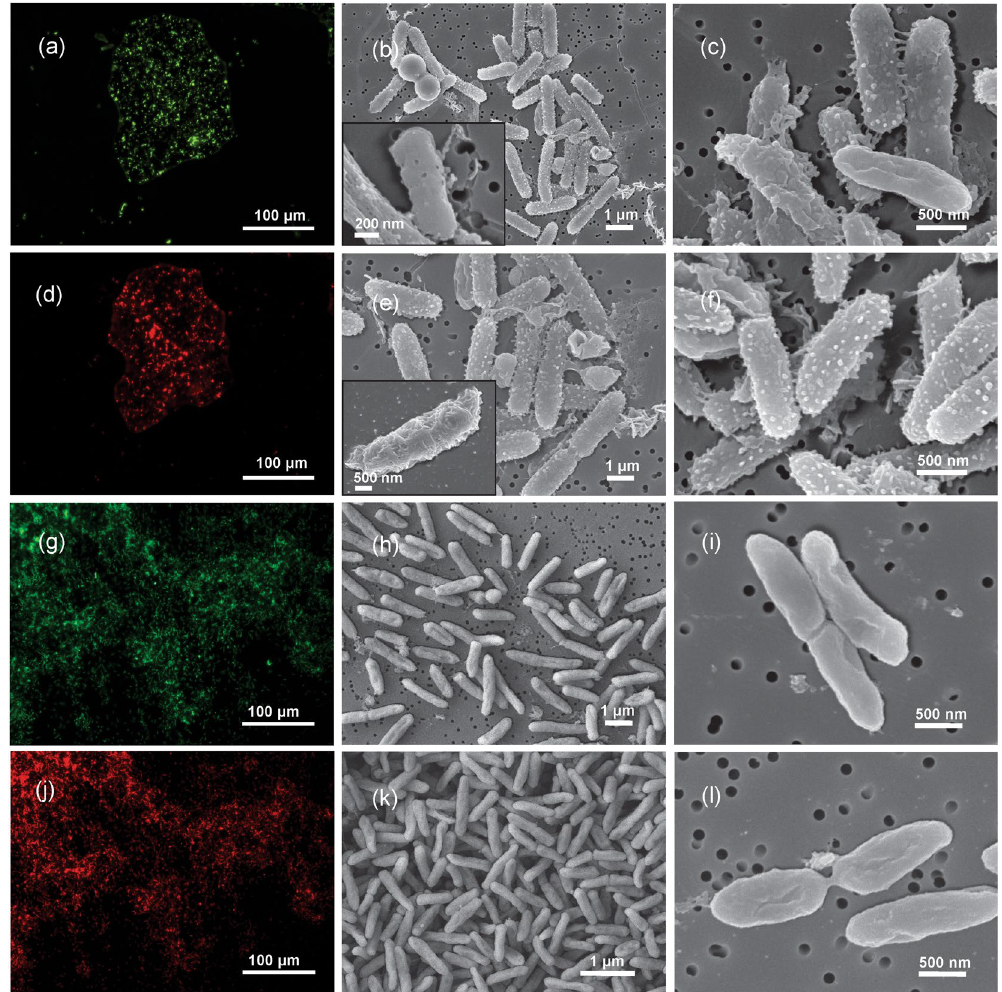
Figure 6. Disruption of the bacterial wall in Gram negative bacteria. Permeability of the membranes (SYTO/ PI live/dead for fluorescence detection of dead/live bacteria (green/red)) in the case of E. coli ( a , d ) and P. aeruginosa ( g , j ) as well as morphological characteristics of the bacterial cells (SEM images) for E. coli ( b , c , e , f ) and P. aeruginosa ( h , i , k , l ) obtained after exposure to C -template with Au nano-features containing 7 wt.% of pure